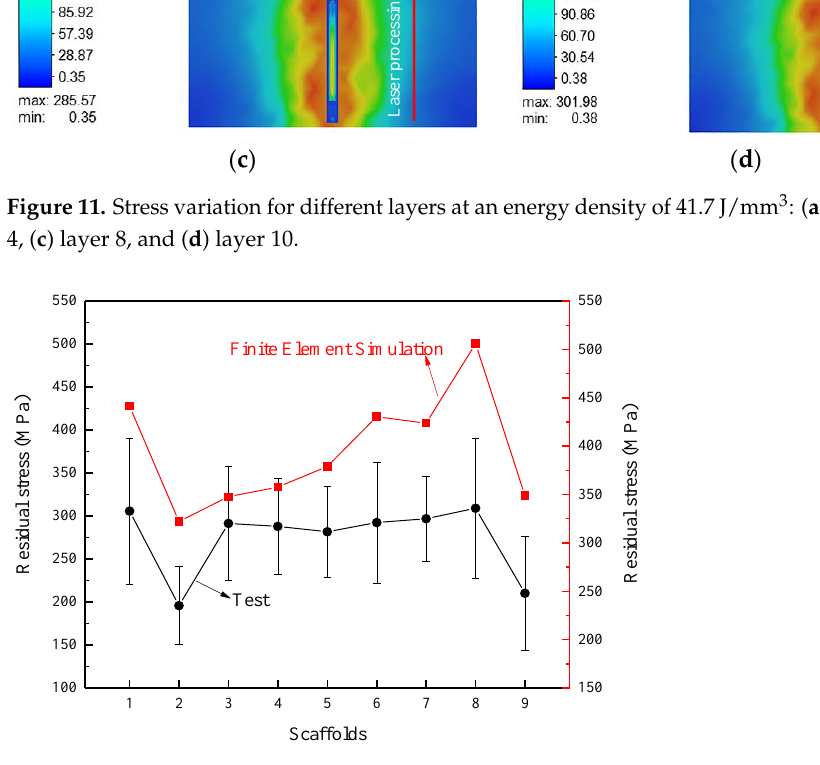
Figure 11. Stress variation for different layers at an energy density of 41.7 J/mm 3 : ( a ) layer 1, ( b ) layer 4, ( c ) layer 8, and ( d ) layer 10.